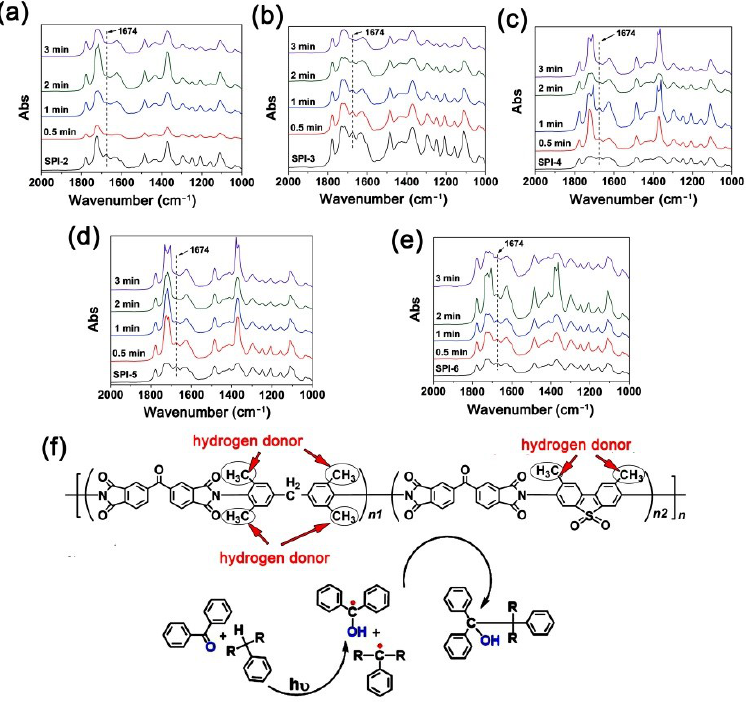
Figure 11. Photocrosslinking of benzophenone carbonyl at 1674 cm − 1 with the exposure time (high-pressure mercury lamp, power: 400 mW/cm 2 ). ( a ) SPI-2; ( b ) SPI-3; ( c ) SPI-4; ( d ) SPI-5; ( e ) SPI-6; ( f ) photocrosslinking mechanisms.